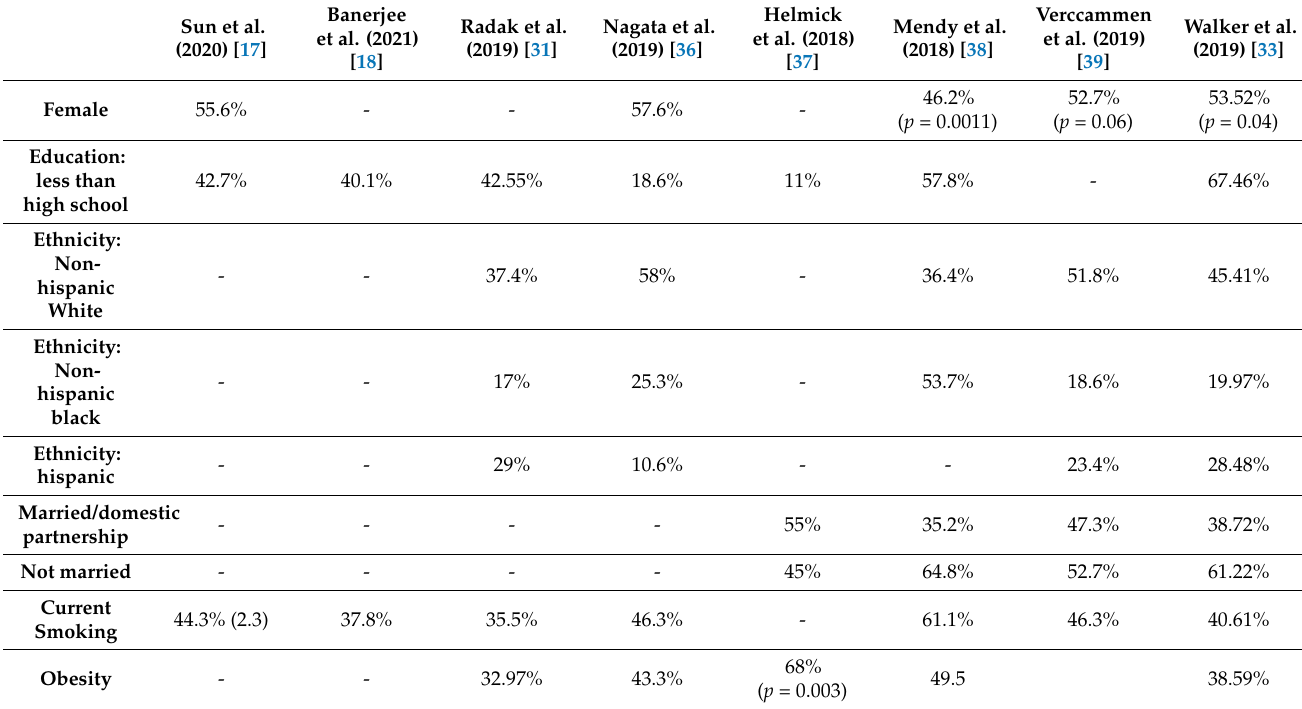
Table 2. Percentage of population under food insecurity, according to several socioeconomic and health characteristics that presented a significant association with cardiometabolic risk (all data are p < 0.001, if not